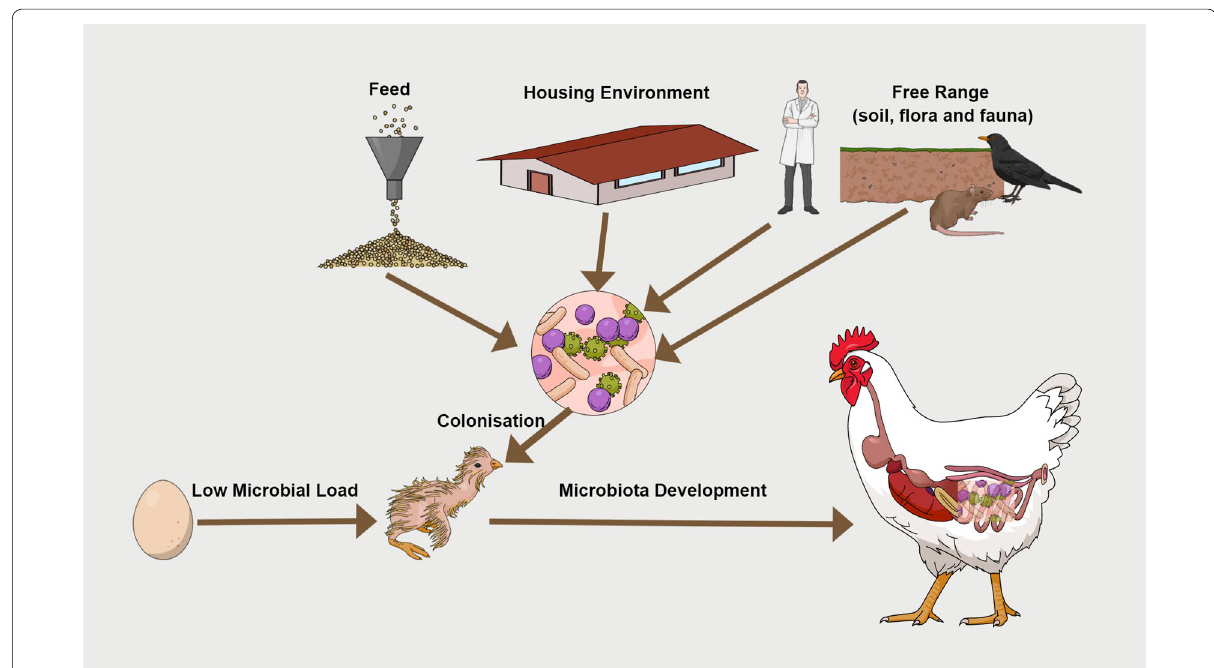
Fig. 6 Feed contains a diverse microbial community and is an active bacterial coloniser in